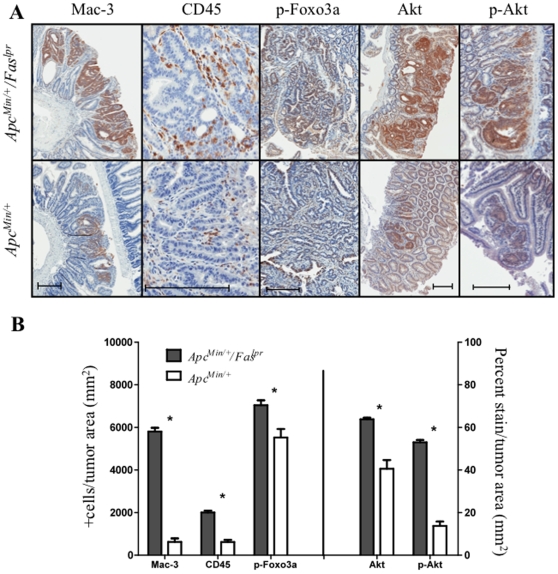
Inflammation in adenomas of ApcMin/
+ and Apc
Min/+
/Faslpr mice.(A) Immunostains for Mac-3, CD45, p-Foxo3a, Akt and pAkt in adenomas from ApcMin/+ and ApcMin/+/Faslpr mice at 30 weeks. (B) Quantitation of Mac-3, CD45, p-Foxo3a, Akt, and pAkt immunostains. Error bars represent standard error of the mean.